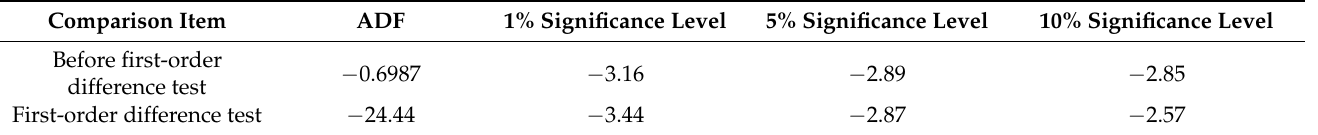
Table 1. Comparison of ADF test